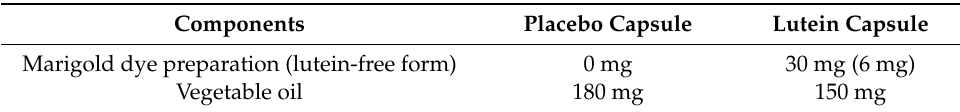
Table 1. Composition of study diet (per capsule).